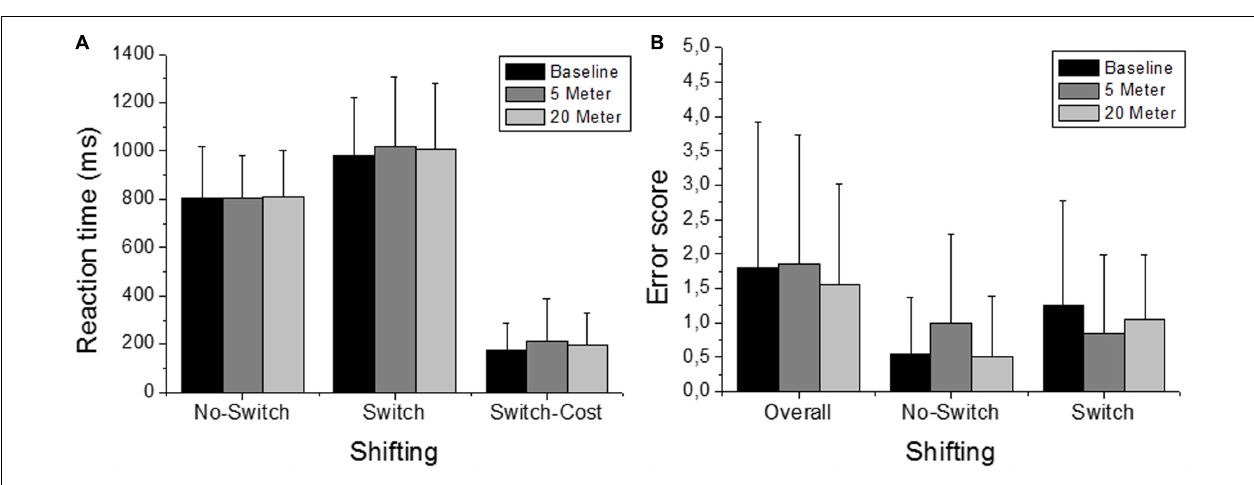
Frontiers in Psychology |